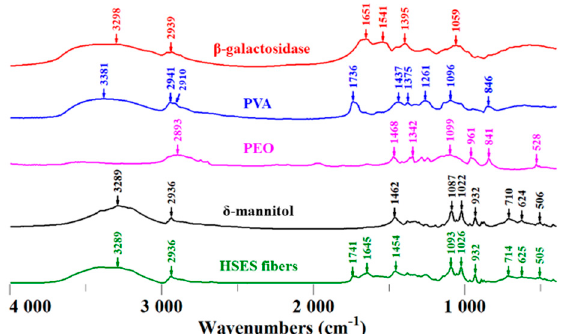
Figure 6. Fourier-transform infrared (FTIR) spectra of β -galactosidase, polyvinyl alcohol (PVA), polyethylene oxide (PEO), δ -mannitol, and the ground electrospun PVA + PEO + mannitol + β -galactosidase.